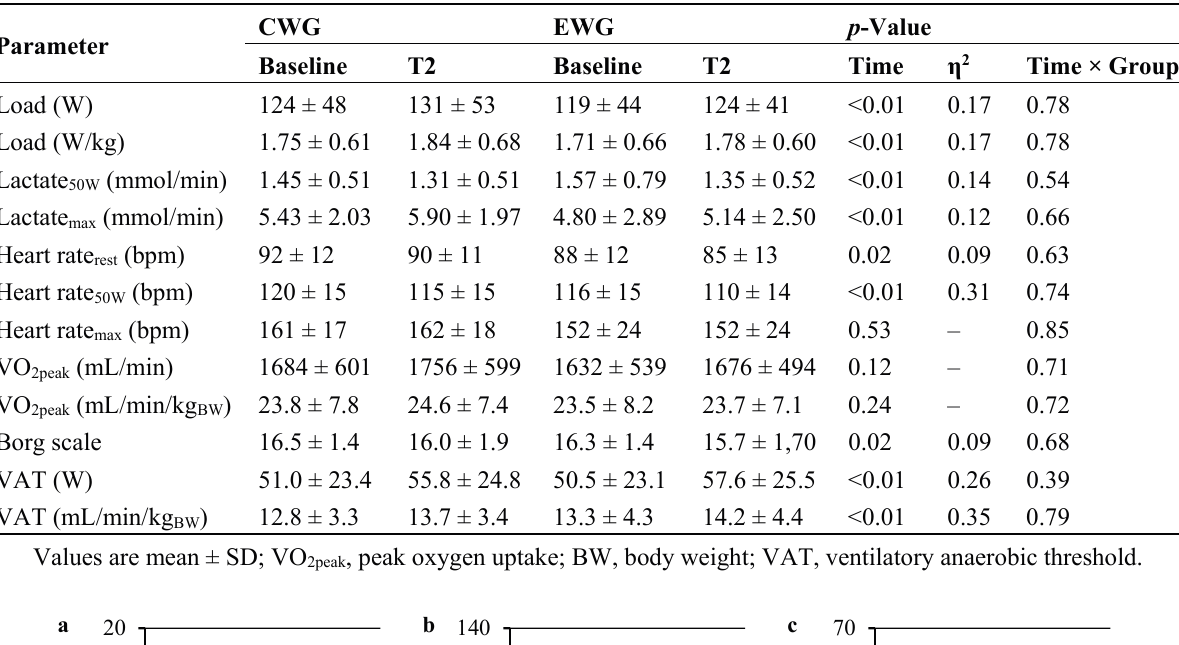
Table 2. Physical capacity parameters at baseline and after training (T2).